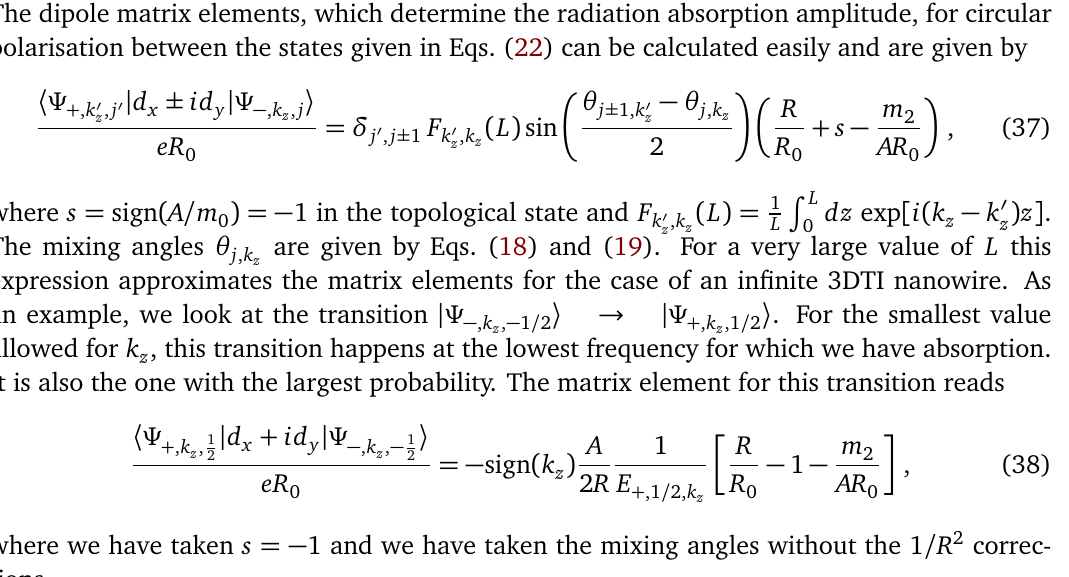
Figure 4: Cuts of the density plot of the probability density in Fig. 3. The black symbols refer to the total density ρ . The other colours refer to: red ρ 1,1 / 2 ( 4 ) ( 3 ) ρ ( 2 ) . Panel (a) is the cut along the horizontal dashed ; green ρ ; orange ρ 1,1 / 2 1,1 / 2 1,1 / 2 line at z = z , while panel (b) is the cut along the vertical dashed line located at u r = ¯ r